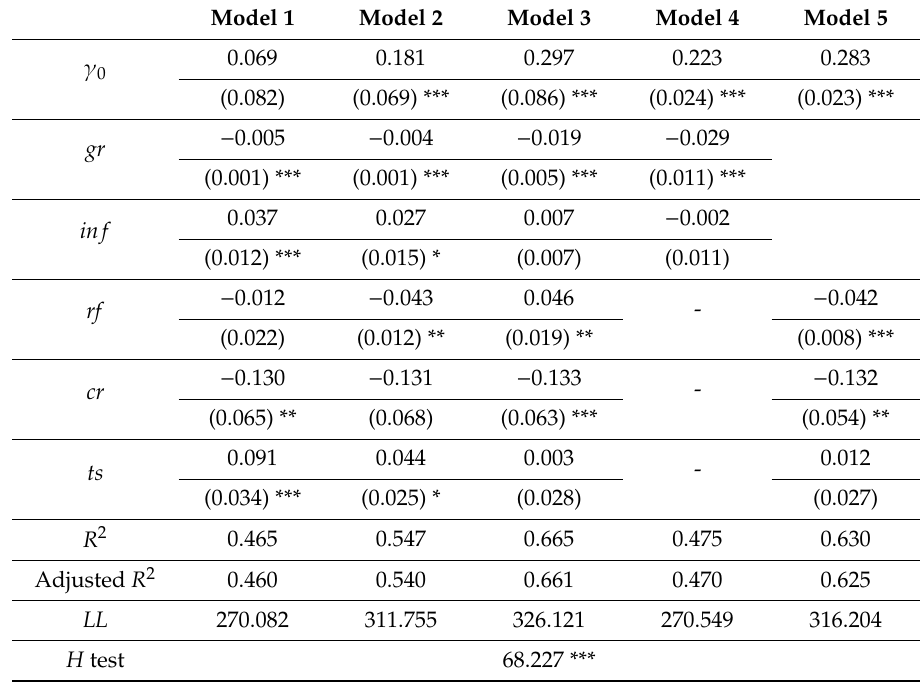
Table 6. Estimation results for panel data